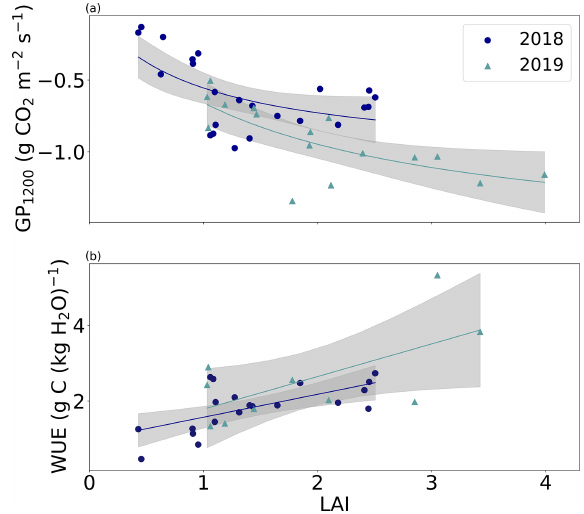
Figure 5. (a) Daily photosynthetic capacity (GP 1200 ) and (b) water use efficiency (WUE) as a function of leaf area index (LAI) dur- ing the two growing seasons. Grey areas represent the uncertainty bands.